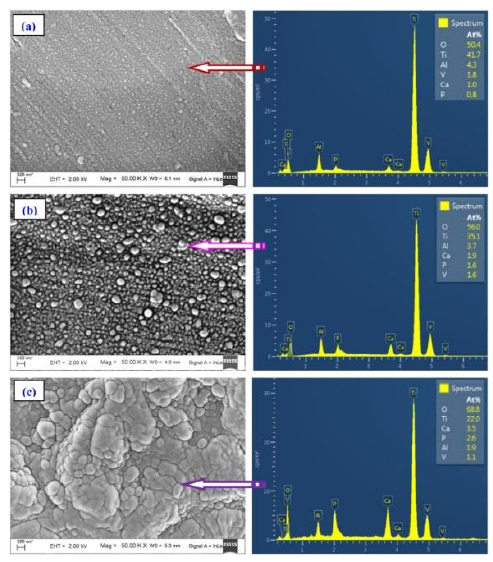
Figure 10. Surface morphology and corresponding EDS analysis of different thick films: ( a ) 400 nm, ( b ) 700 nm, and ( c ) 1000 nm. Reproduced with permission from [40]. Copyright Elsevier, 2018.